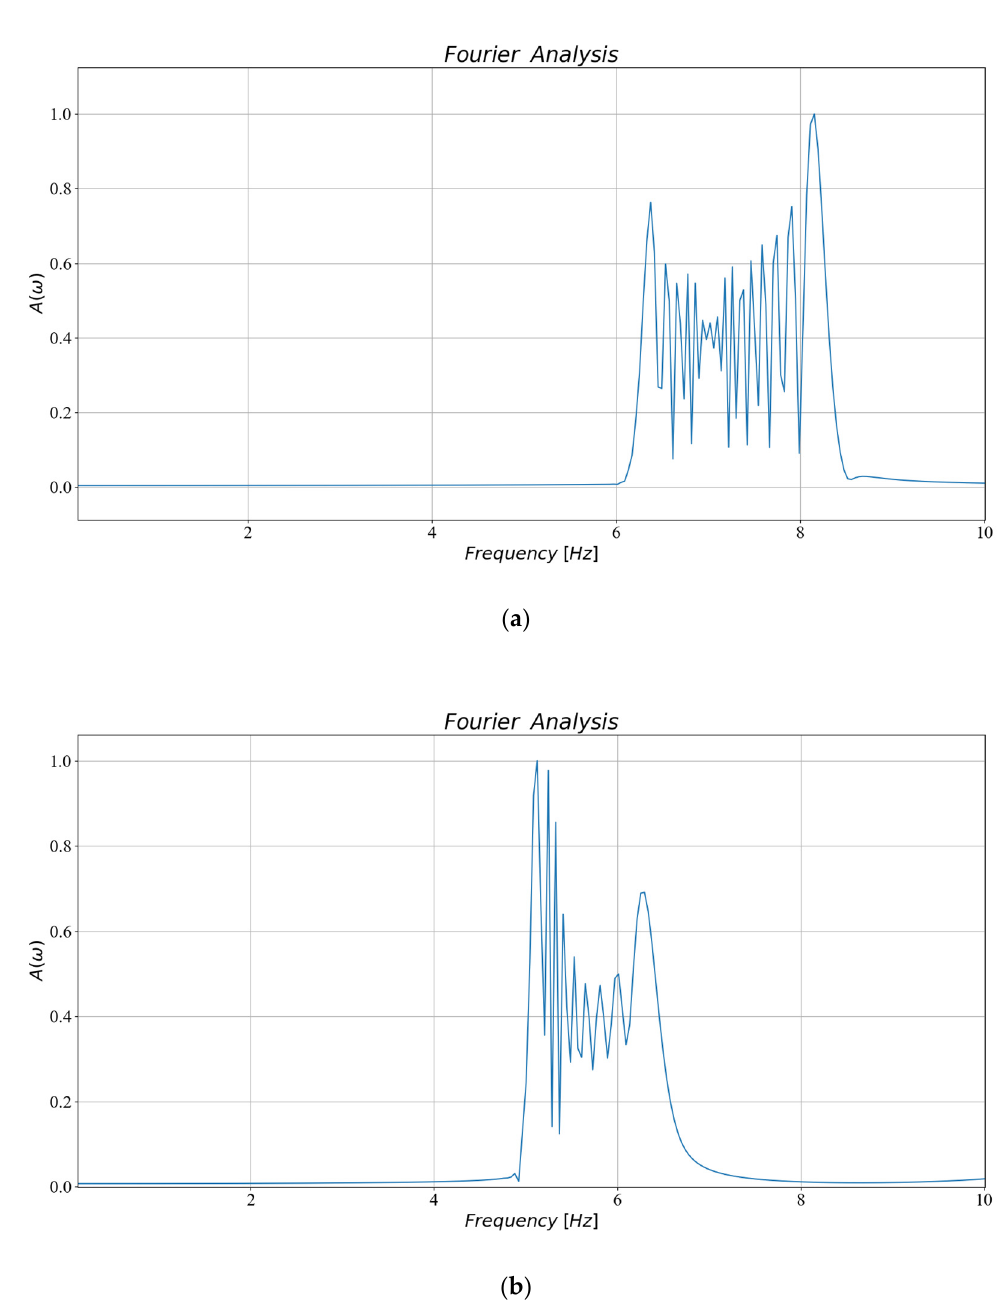
Figure 9. Dimensionless acceleration A( ω ) derived from the analytical solution for a heavy mass m = 38.60 kg traversing the model bridge with speed v = 0.247 m/s and end support stiffness of ( a ) K 1 = 1000 kN/m, K 2 = ∞ . ( b ) K 1 = 100 kN/m, K 2 = ∞ .